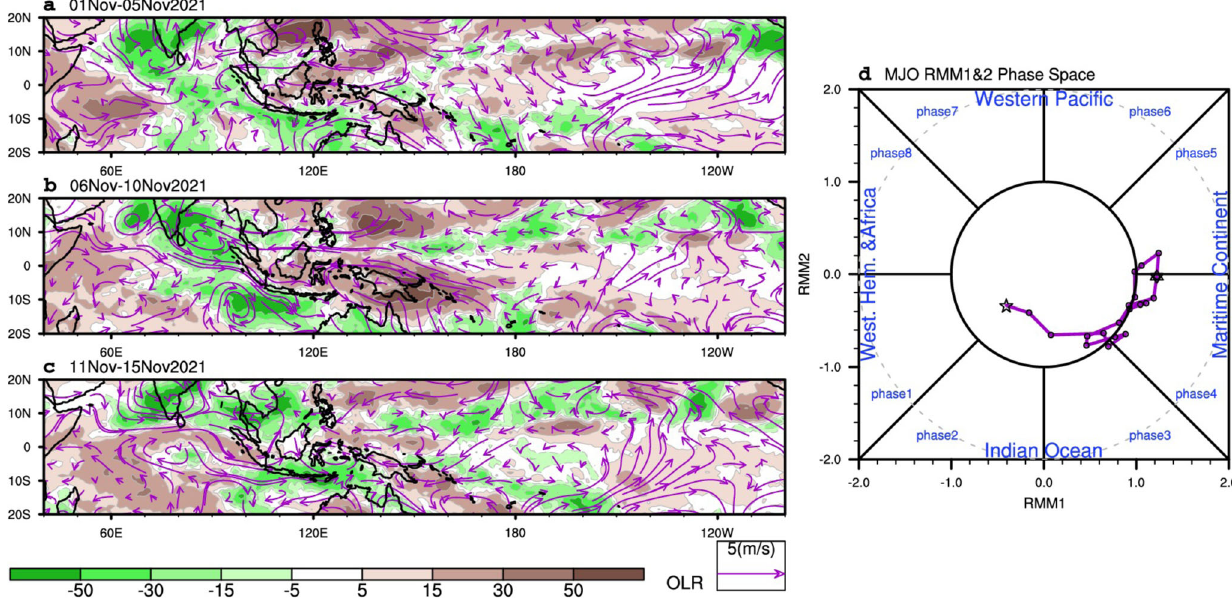
Fig. 5 Quasi-stationary Madden-Julian Oscillation (MJO) in November 2021. Pentad mean of fi ltered OLR (see ‘ Data ’ ) and 850 hPa winds anomalies associated with the MJO during ( a ) November 1 – 5, b November 6 – 10, and c November 11 – 15, 2021. d Real-time Multivariate MJO (RMM) indices shown in the phase plane expanded by RMM1 and RMM2 from November 1 to November 20, 2021. MJO stays in the western Maritime Continent (Phase 4) from November 1 to 20,